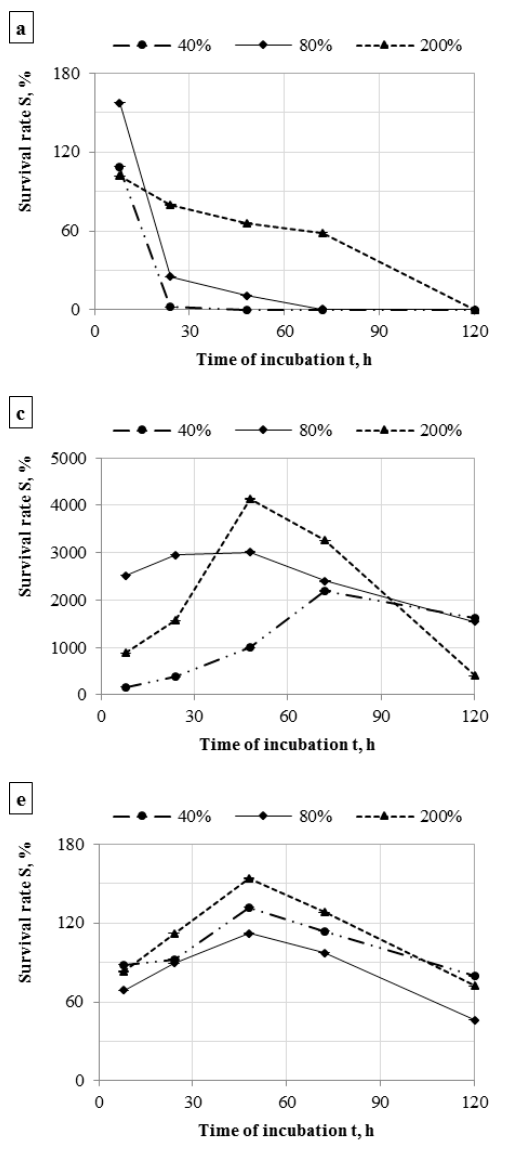
Figure 5. The survival rate of bacteria during incubation on the filter materials, number of samples n = 6 ( a ) Escherichia coli ; ( b ) Staphylococcus aureus ; ( c ) Bacillus subtilis ; ( d ) Candida albidans ; ( e ) Aspergillus niger ; and ( f ) the survival rate of microorganisms after 120 h of incubation on the filter materials with different moisture content.